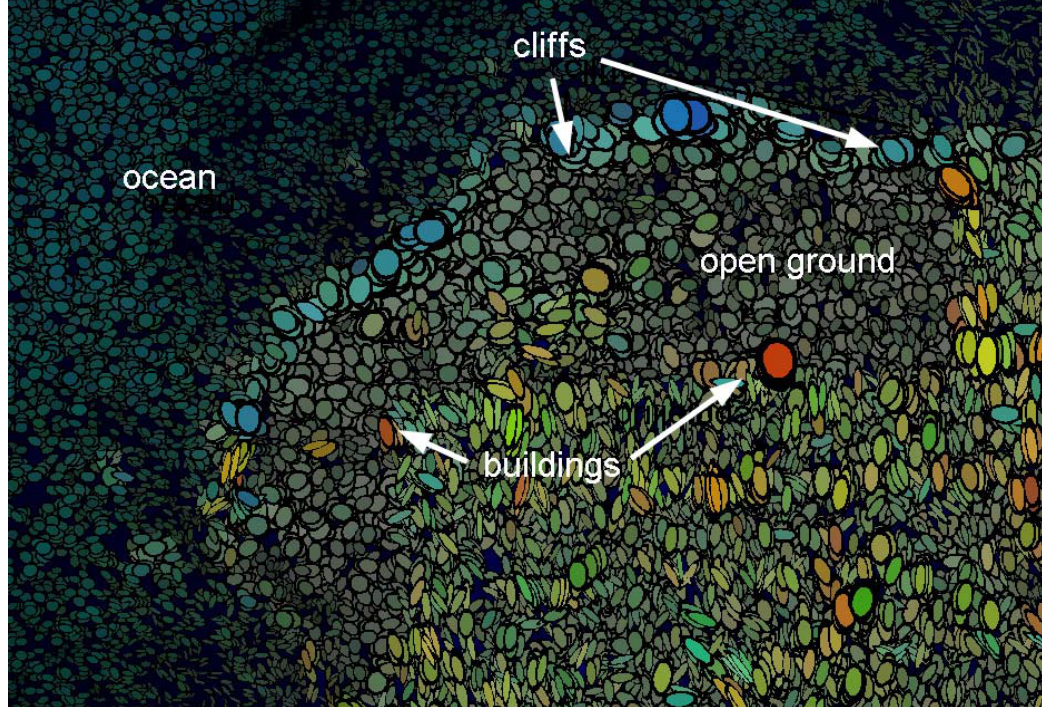
Figure 3. Detail of San Francisco dataset over the area around Lincoln Park, showing the different patterns evident for different landscape